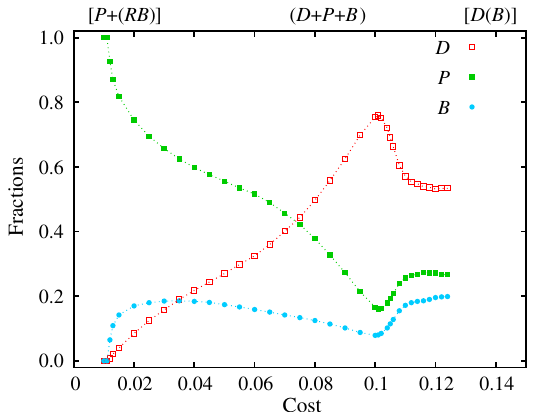
FIG. 7. Cross section of the phase diagram depicted in Fig. 5, as obtained for (cid:1) ¼ 0 : 55 . Depicted are stationary fractions of the four competing strategies in dependence on (cid:2) . Stable solutions are denoted along the top axis. Unlike in Fig. 6, here the D þ P þ B ! D ð B Þ phase transition is discontinuous because the amplitude of oscillations diverges independently of the system size (see Fig. 8 for details) as (cid:2) increases.